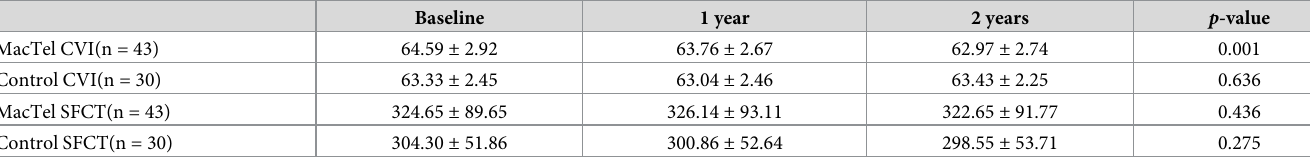
Table 2. Choroidal vascularity index (%) and subfoveal choroidal thickness changes over time.